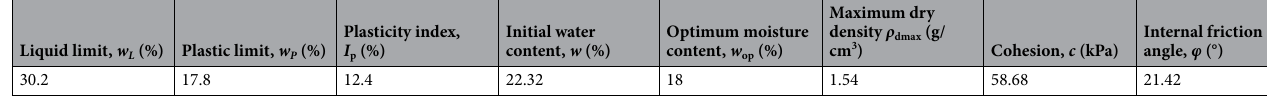
Table 1. Physical properties of the loess.